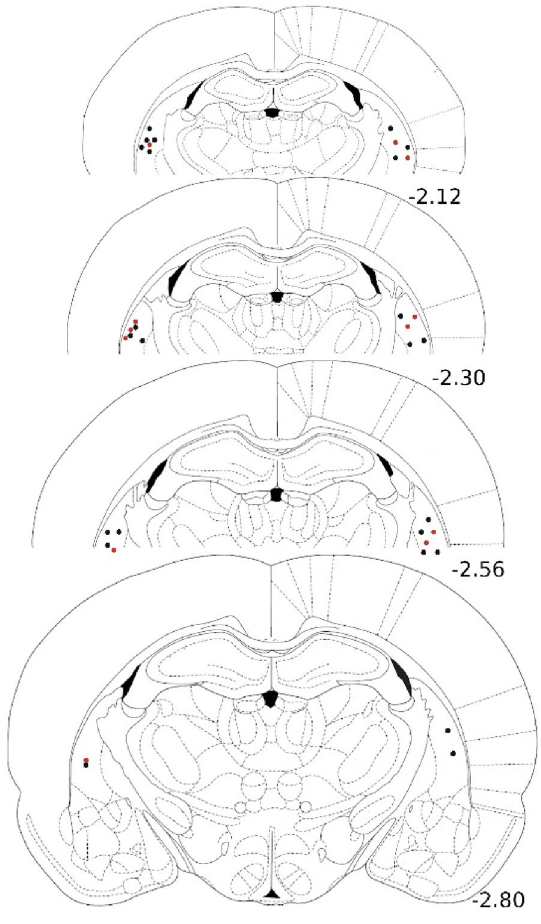
Figure 4. A schematic representation of the ipsilateral and contralateral electrode placements. The black and red dots represent the electrode placement in non-cochlea-lesioned and cochlea-lesioned rats, respectively.